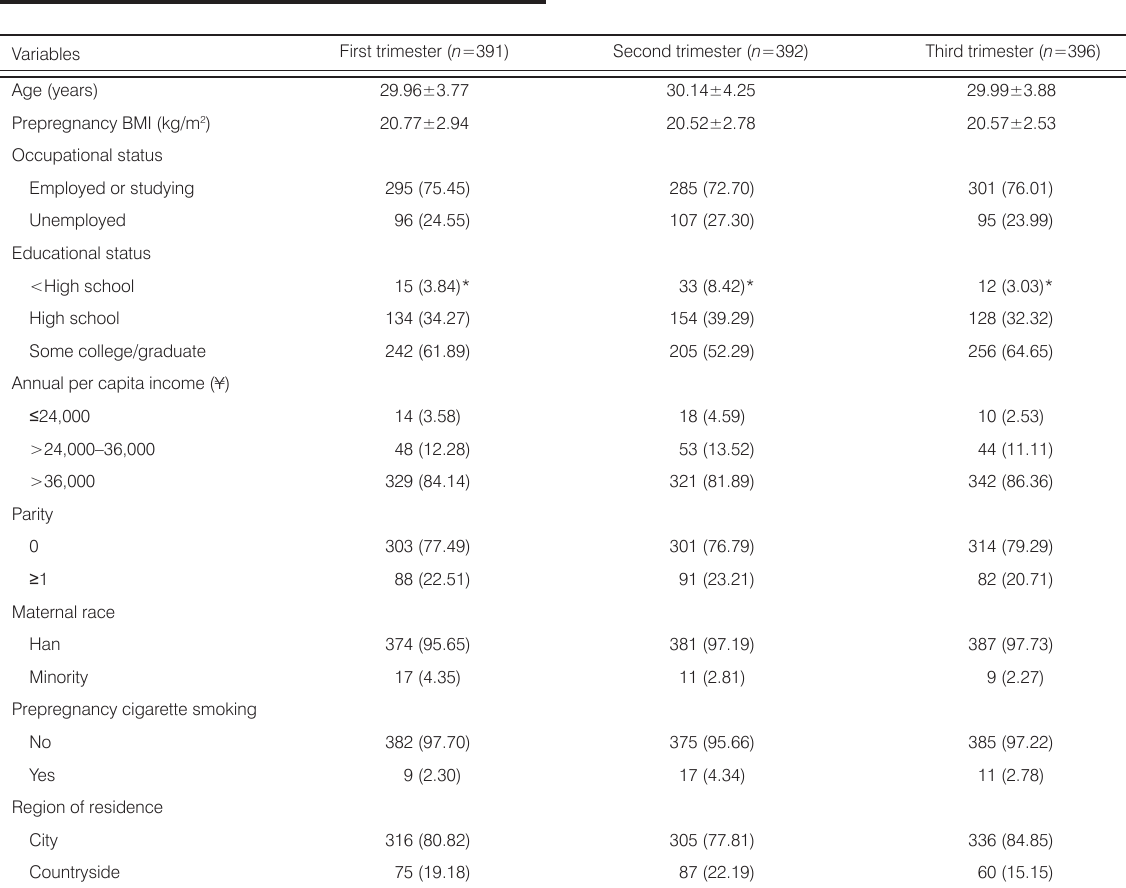
Table 1. Pregnant women’s characteristics.